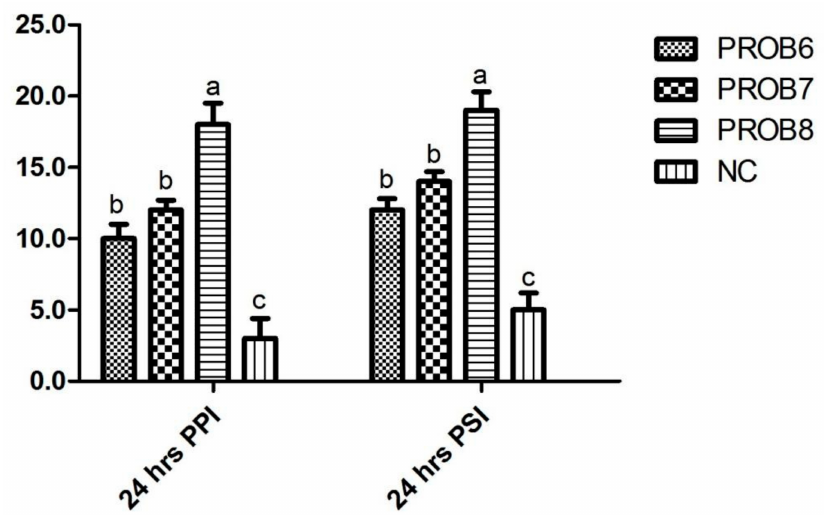
Figure 4. Cell-mediated response to DNCB in different probiotic-supplemented and control groups. Means with different superscripts (a, b, c) are significantly different ( p < 0.05). PROB6 = L. plantarum (1 × 10 6 CFU) supplemented group in feed; PROB7 = L. plantarum (1 × 10 7 CFU) supplemented group in feed; PROB8 = L. plantarum (1 × 10 8 CFU) supplemented group in feed; NC = infected, non-medicated control group.